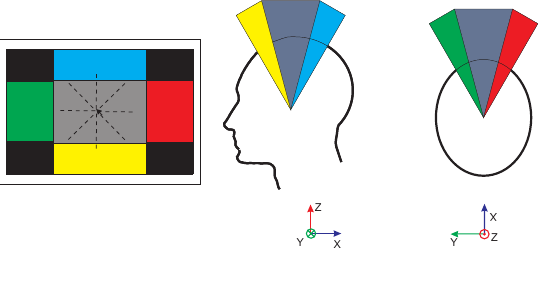
Figure 9. Control space of incremental method. If the user looks at the grey area, the pointer stops. If the user looks at the red region, the pointer moves towards the right.